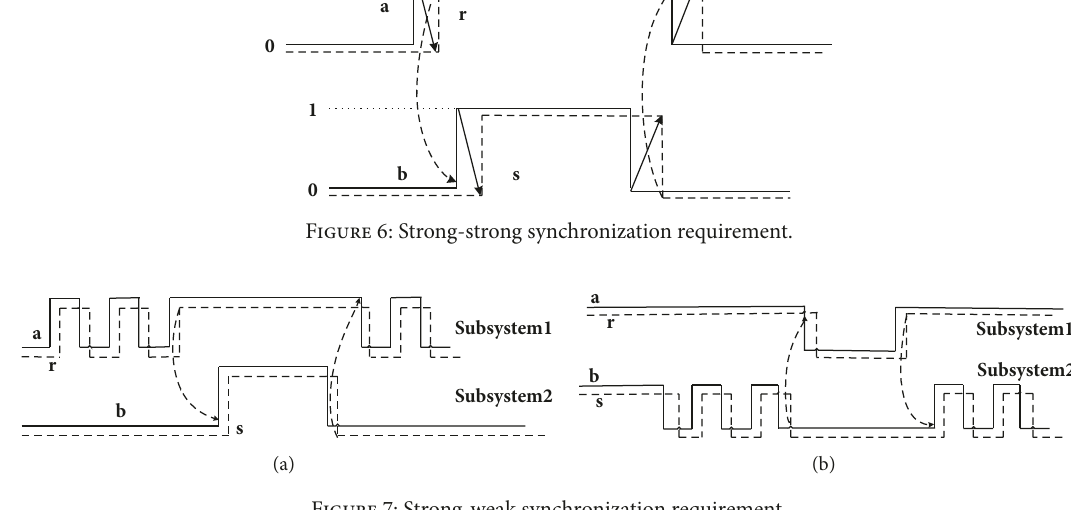
Figure 7: Strong-weak synchronization requirement.